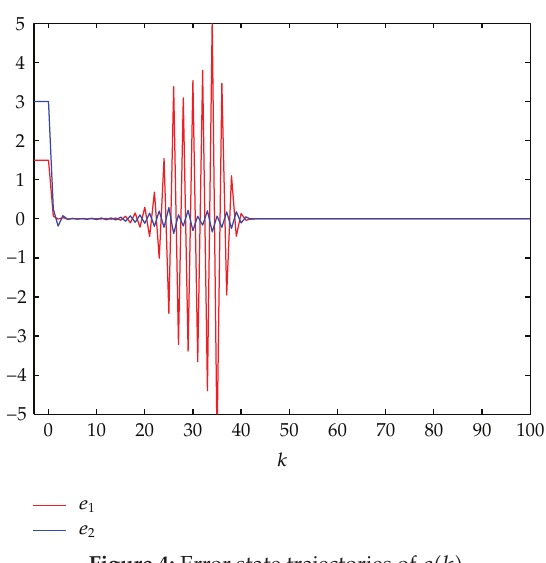
Figure 4: Error state trajectories of e (cid:2) k (cid:3)